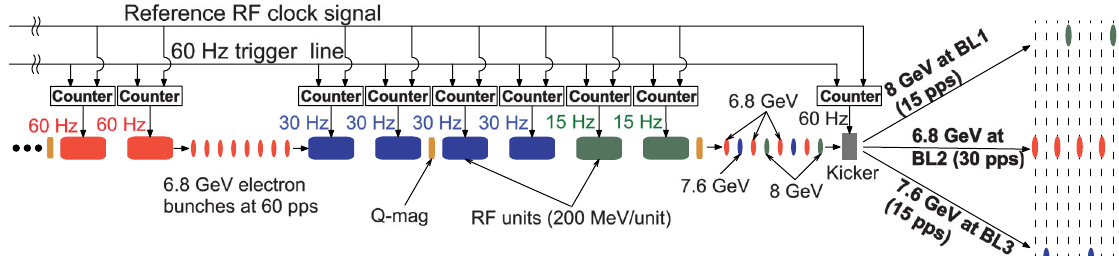
FIG. 1. An example of accelerator setup for multienergy